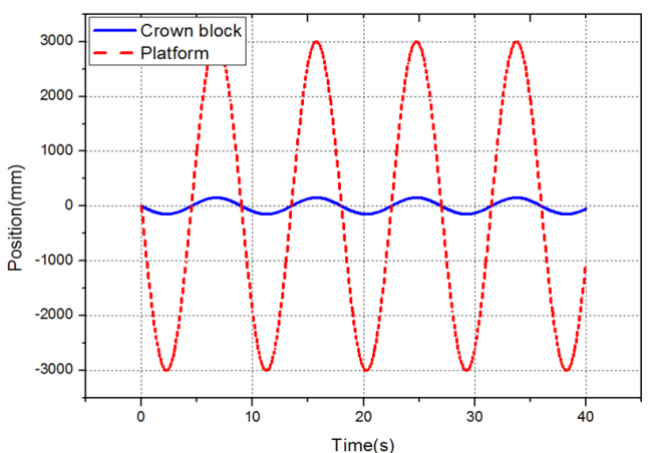
Figure 10. Position of the crown block and frame.